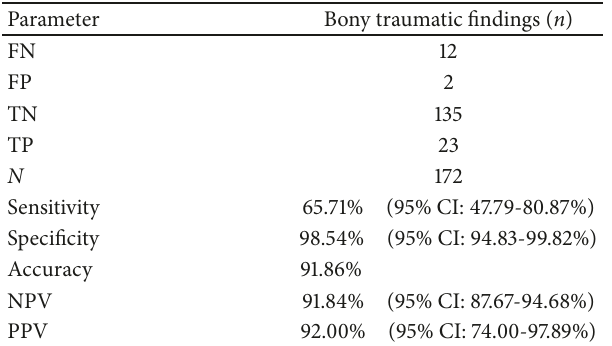
Table 2: Results of plain digital pelvic radiographs in pediatric trauma